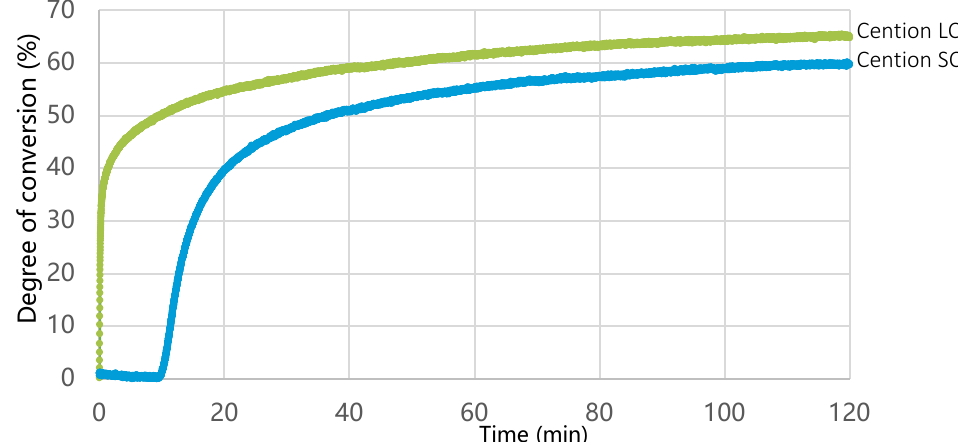
Figure 8. Degree of conversion as a function of time for Cention LC (green line) and Cention SC (blue line).